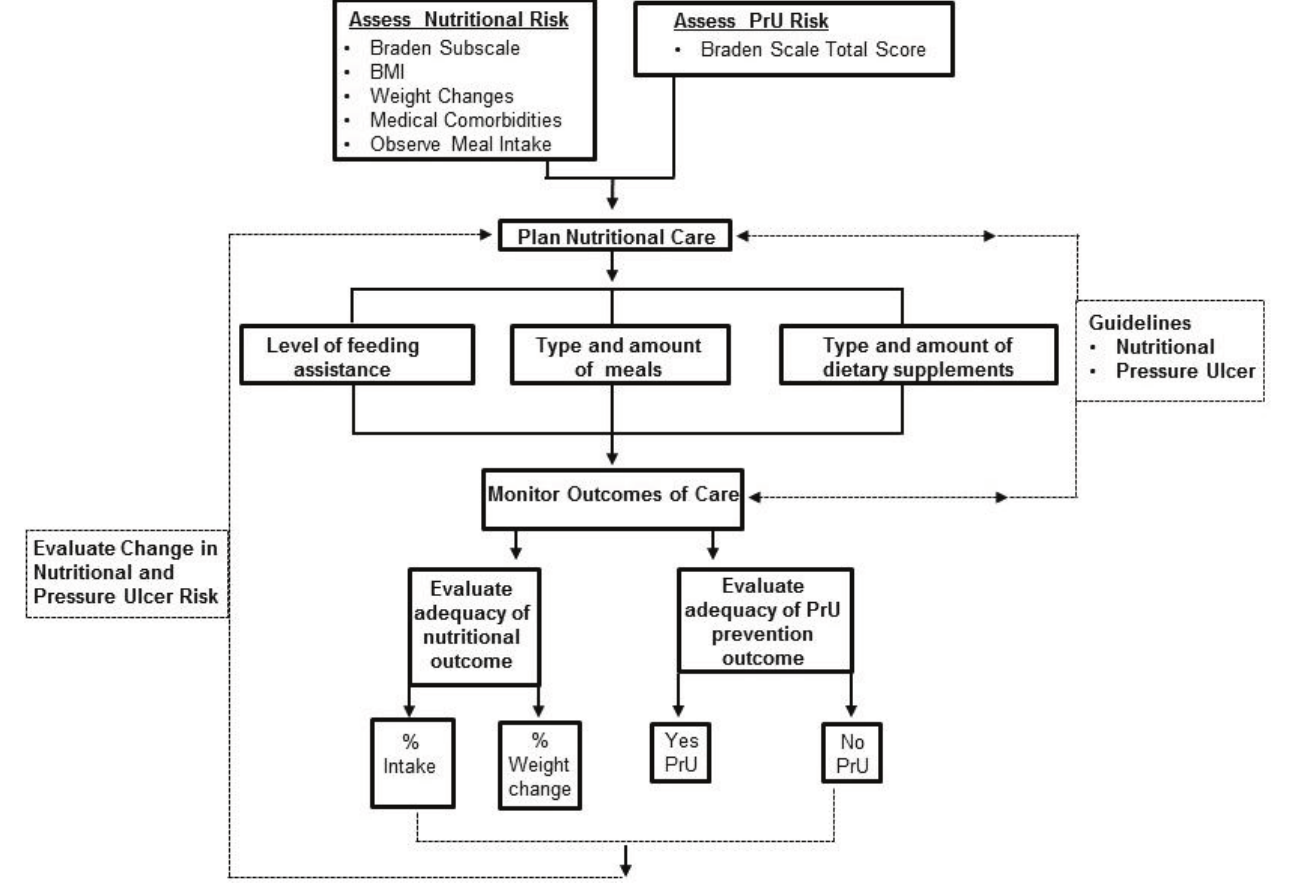
Figure 1. Framework for Nutritional Risk Evaluation and Care Planning in Relation to high pressure ulcer (PrU)